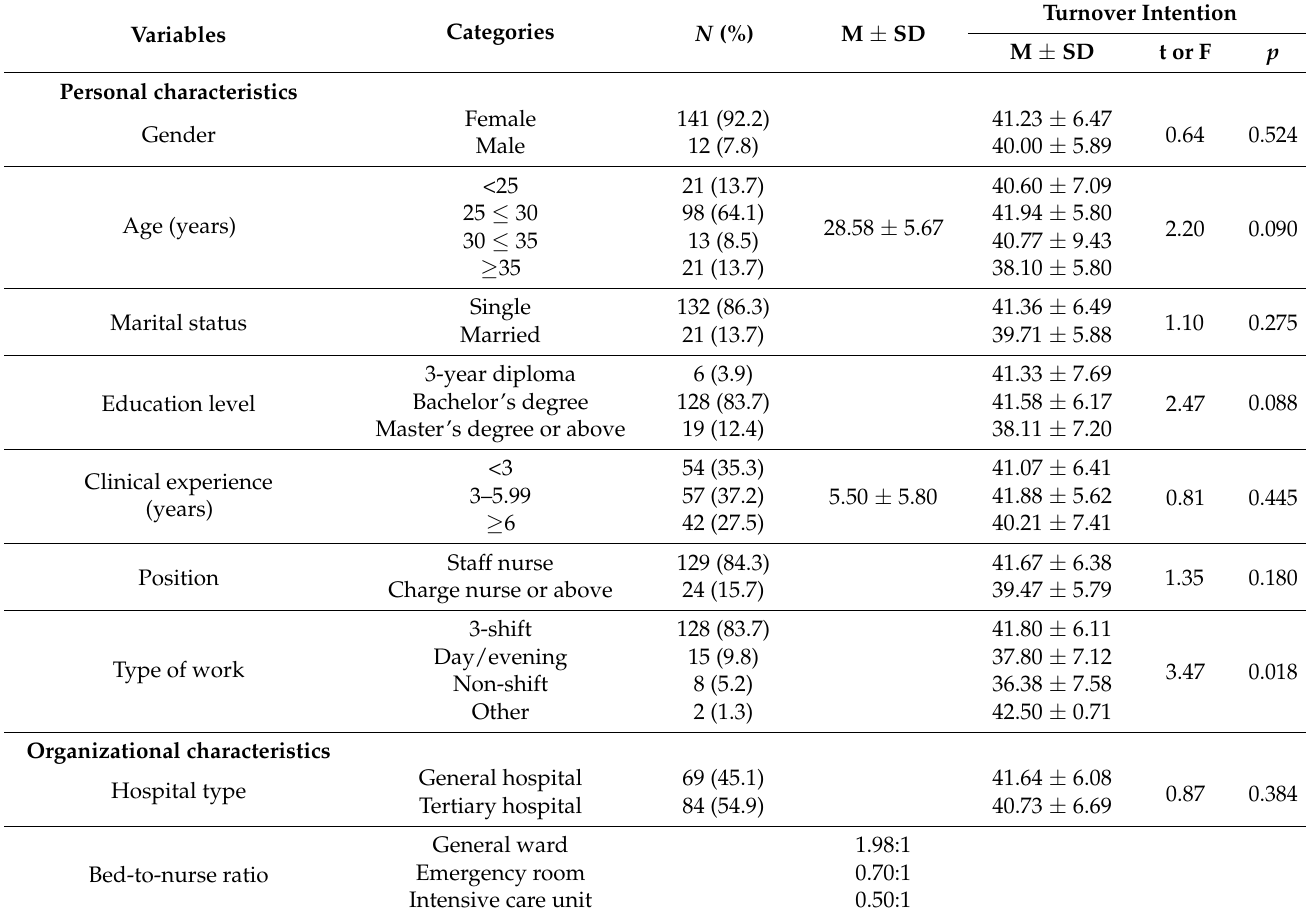
Table 1. General characteristics and turnover intention ( N =